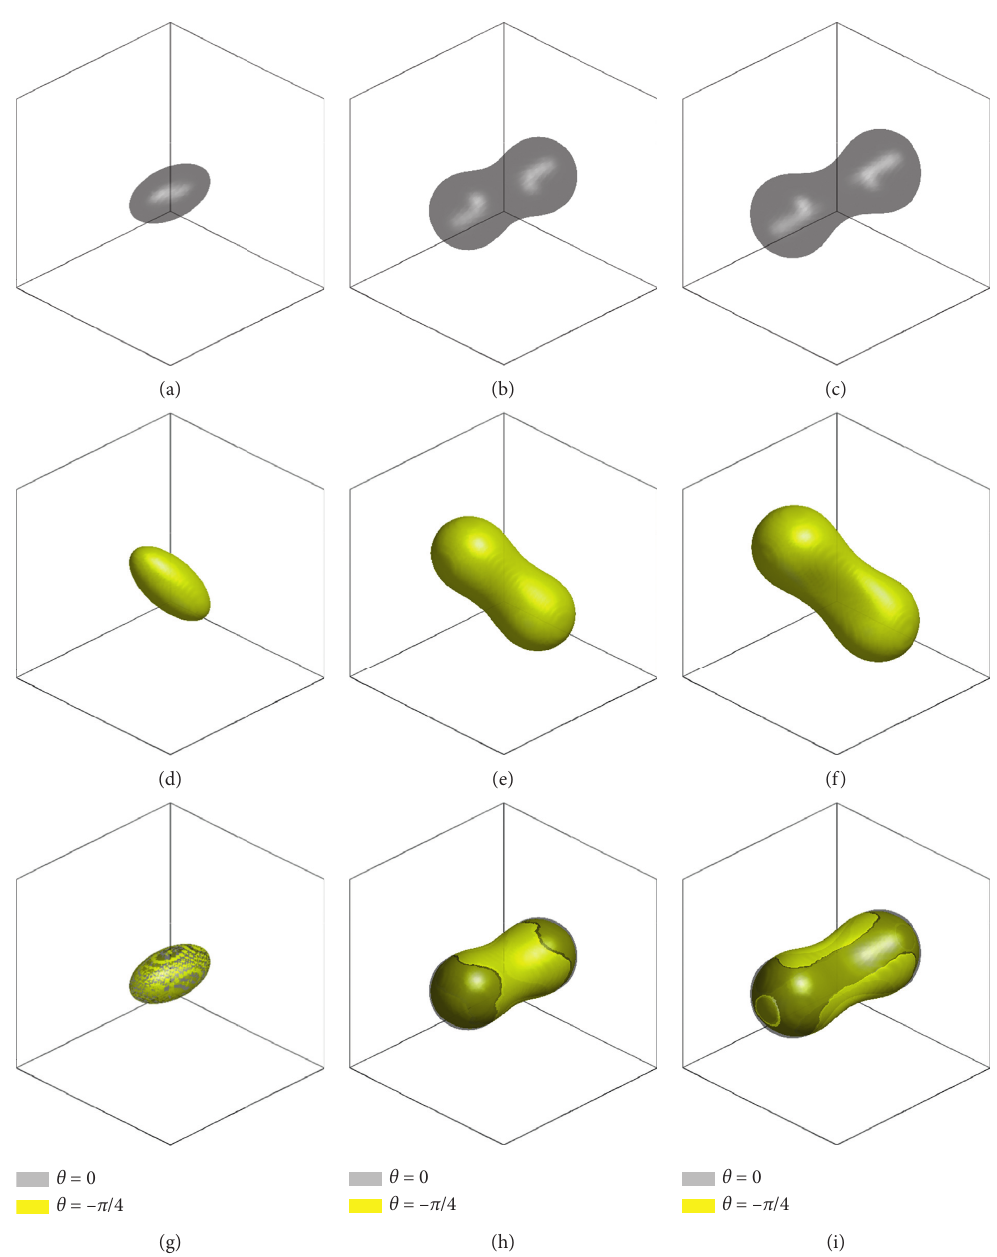
Figure 9: (a–c) Snapshots of isosurface ϕ � 0 for evolution in equation (9) using the isotropic scheme at t � 0, 600 Δ t , and 1000 Δ t , respectively. (d–f) Snapshots of isosurface ϕ � 0 for evolution in equation (10) using the isotropic scheme at t � 0, 600 Δ t , and 1000 Δ t , respectively. (g–i) Overlapped isosurfaces ϕ � 0 for each column at t � 0, 600 Δ t , and 1000 Δ t , respectively. Note that the axes are limited to show only (− 0 . 6 , 0 . 6 ) 3